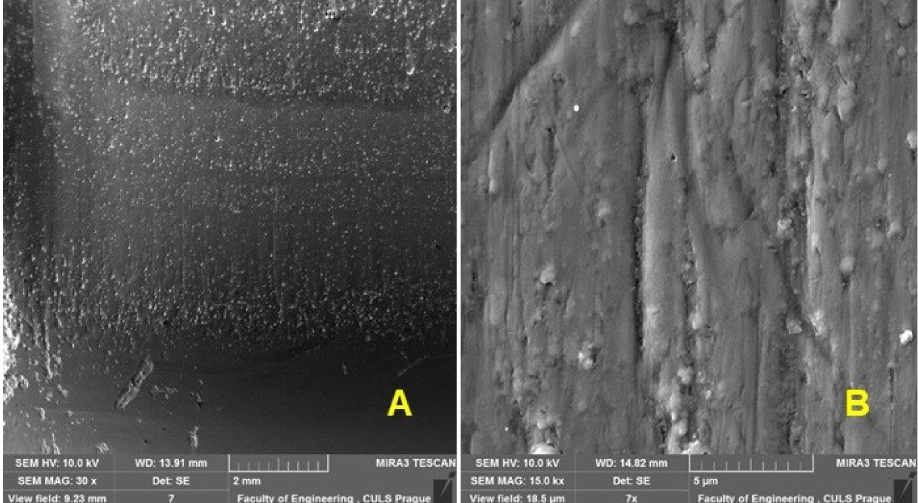
Figure 12. SEM analysis of the surface—the leading surface of the rubber disc during the enamel surface wear process: ( A ): a macroscopic image of the surface (MAG 30 × ), ( B ): a detailed image of the surface (MAG 15.0k ×